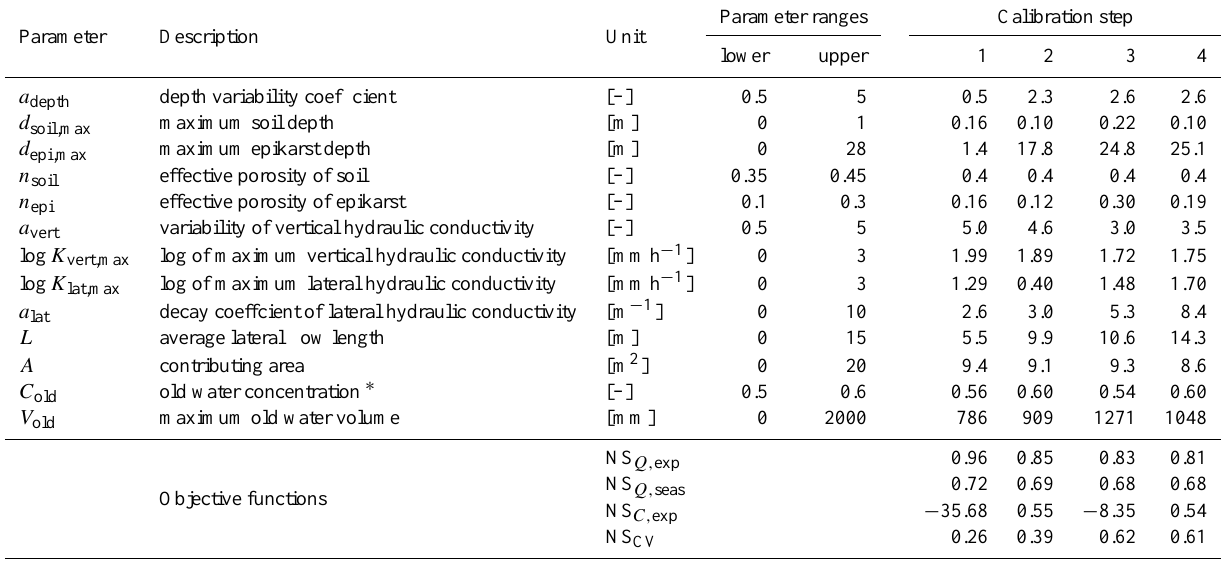
Table 1. Parameter table, calibration ranges, optimized parameter sets and their efficiencies for all four calibration steps.